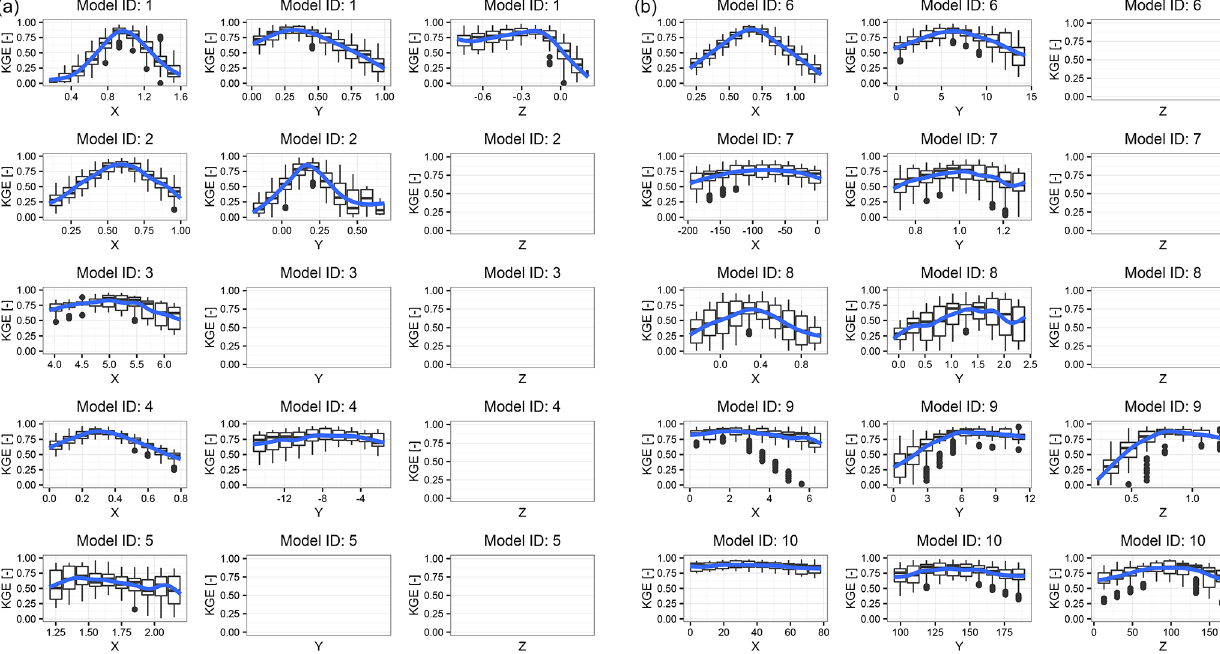
Figure 7. Results of the model parameters’ sensitivity analysis. The variation of the model performances due to a variation of one of the optimal parameters and assuming constant the others is presented as a boxplot. The procedure is repeated for each model and the blue line represents the smooth line passing through the boxplot